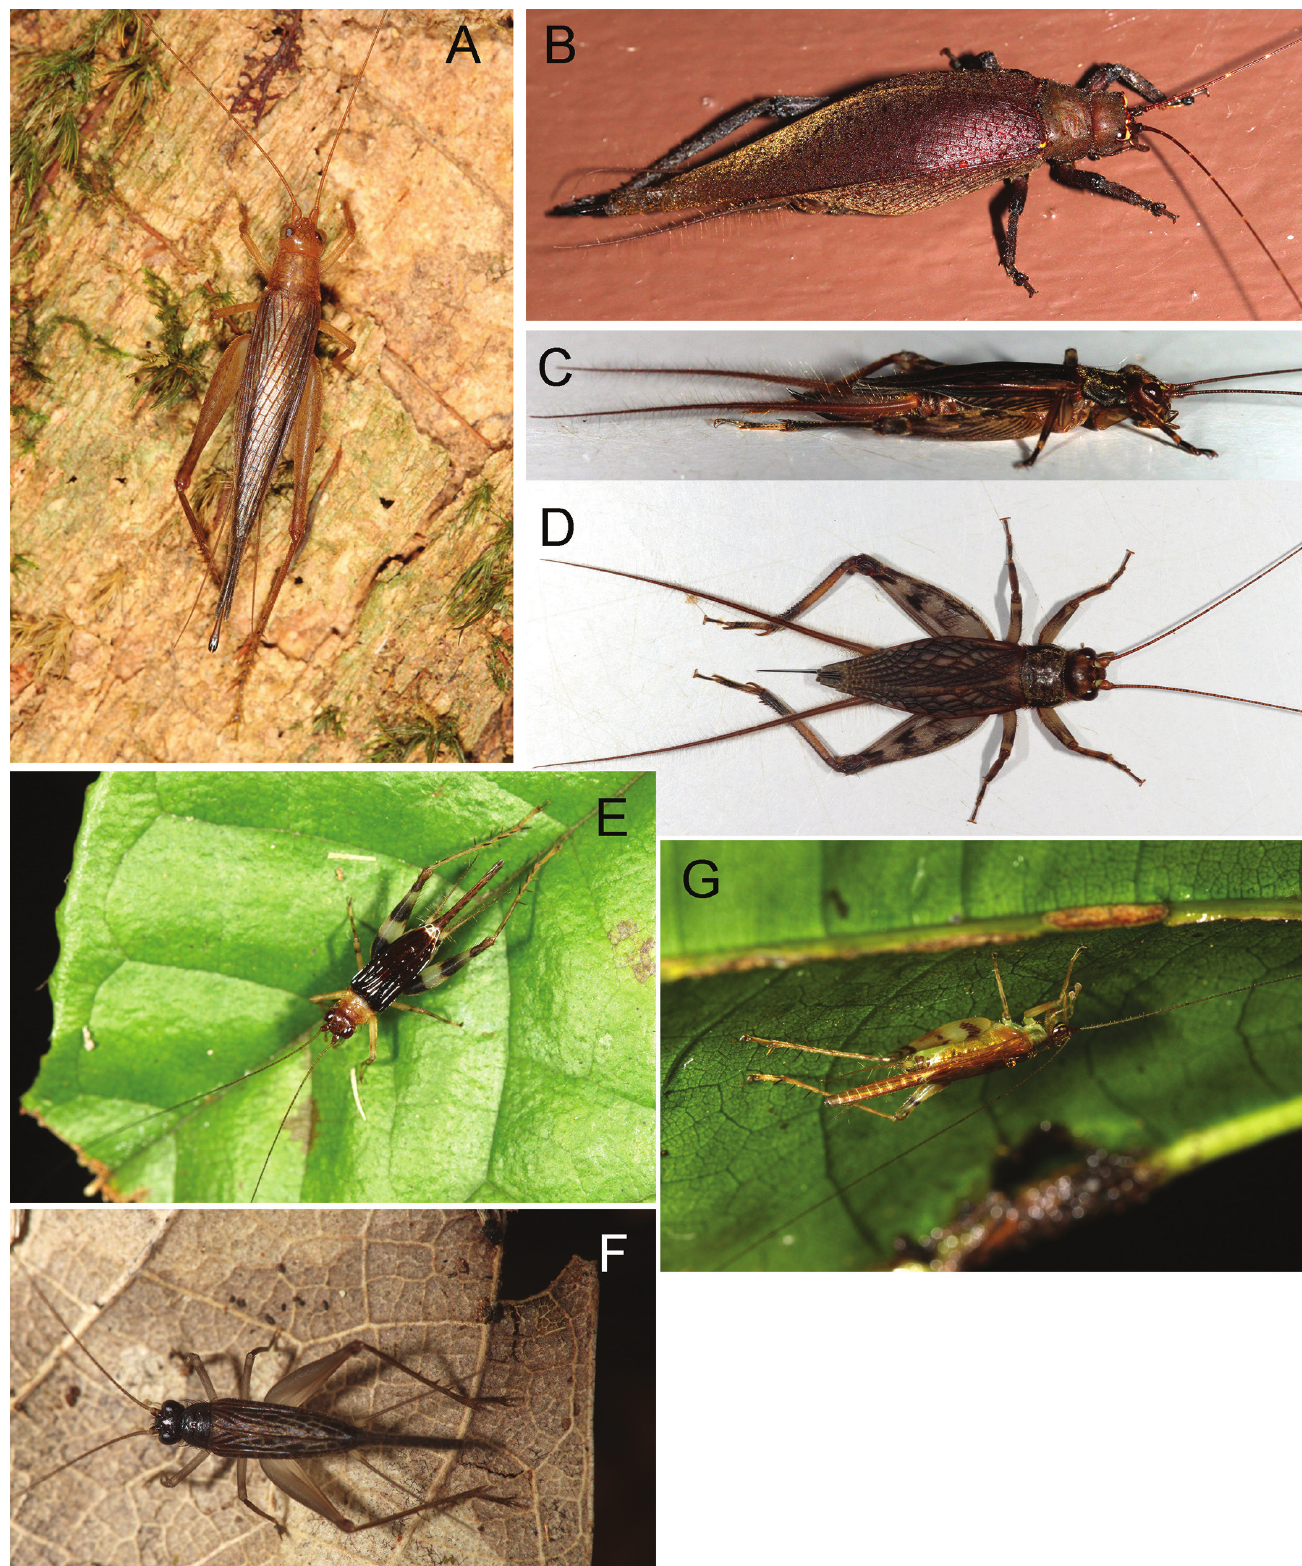
Fig. 10. Gryllidae: Podoscirtinae: A. Aphonoides sp.; B. Sonotrella ( Megatrella ) sp.; Grylloidea: Pteroplistinae: C, D. Pteroplistes sp.; Trigo- nidiidae: Trigonidiinae: E. Amusurgus or Metiochodes sp.?; F. Amusurgus or Paratrigonidium sp.?; G. Paratrigonidium